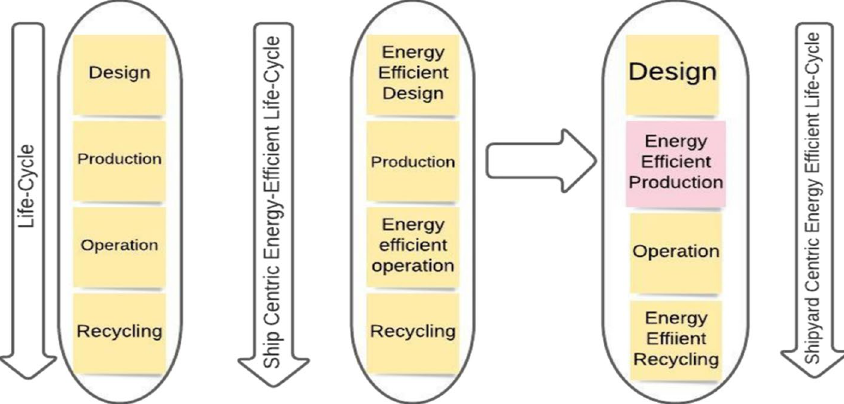
Fig. 2 Stages of ship life cycle and energy management. Source : adapted from (Ölcer